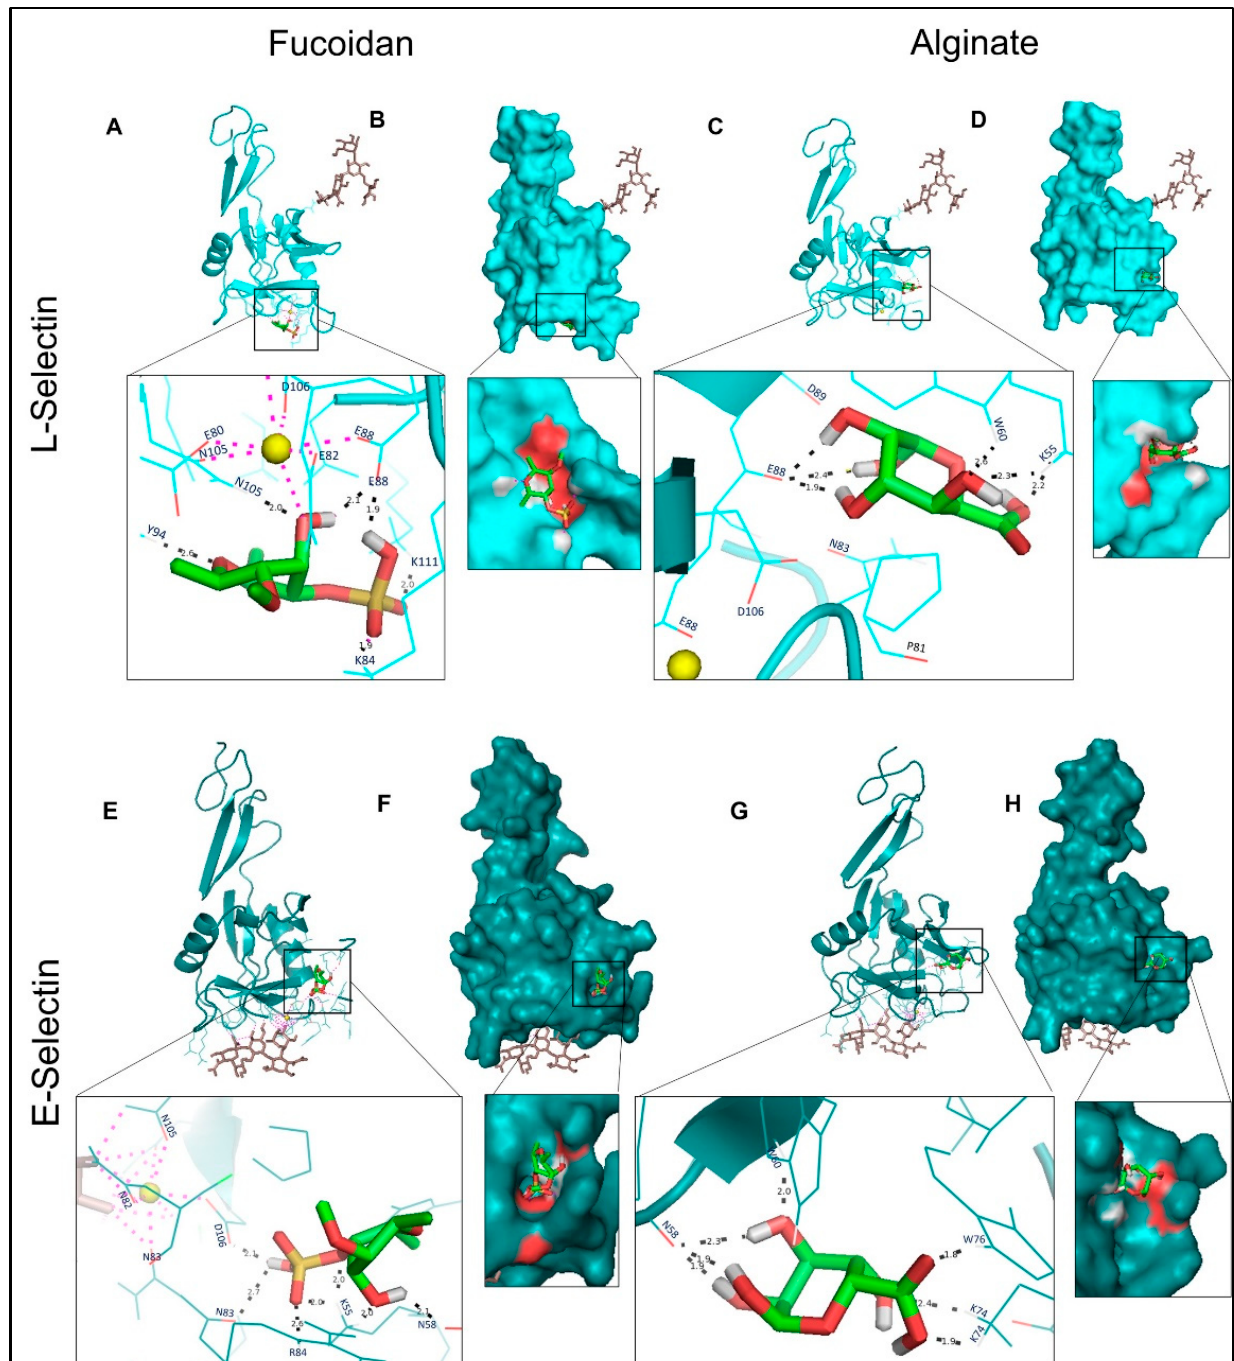
Figure 4. Molecular docking of L-and E-selectins with fucoidan and alginate. ( A , C , E , G ): 3D structures of proteins bound with N-linked glycan moieties (brown) and zoomed ligand-binding pocket. Black and purple dotted lines, respectively, describe the H-bonds and Ca 2+ (yellow ball) coordination bonds. ( B , D , F , H ): molecular surface representation, and the red patches on the surface represent electrostatics of the binding cavity.